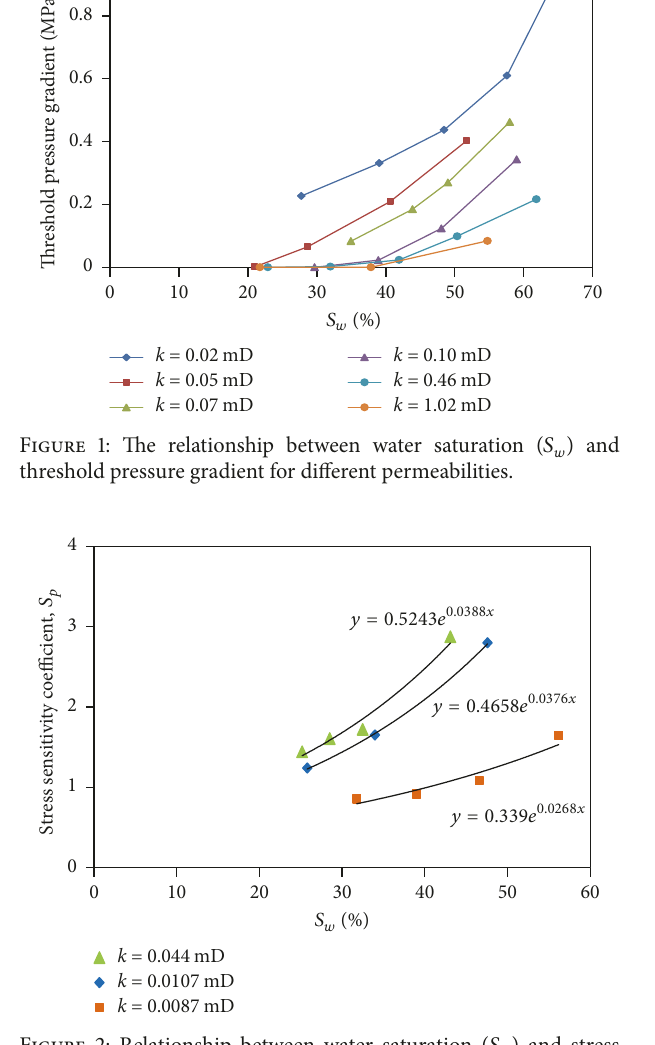
Figure 2: Relationship between water saturation ( 𝑆 𝑤 ) and stress sensitivity coefficient.